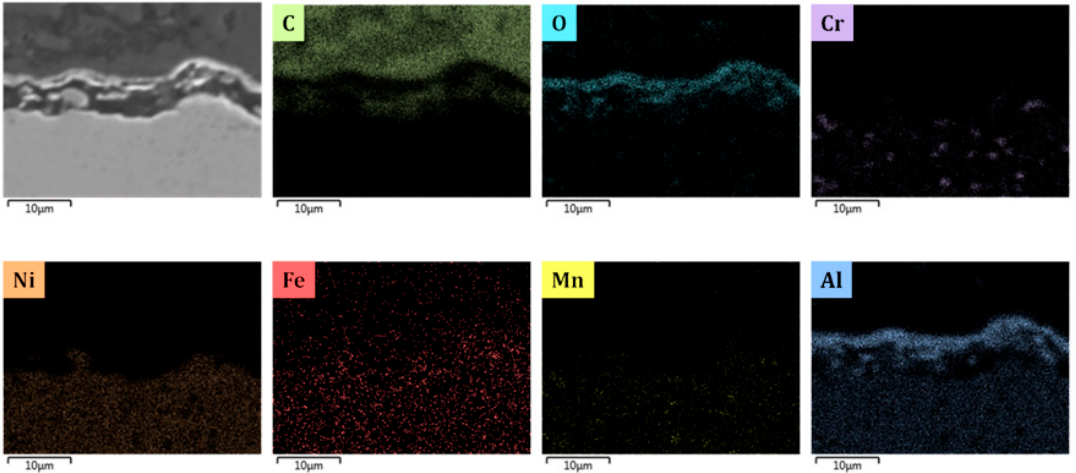
Figure 11. Cross-sectional elemental mapping of a CoatAlloy ™ sample subjected to the steam / air pretreatment followed by presulfiding. Magnification: 3000 × , accelerating voltage: 15 kV.